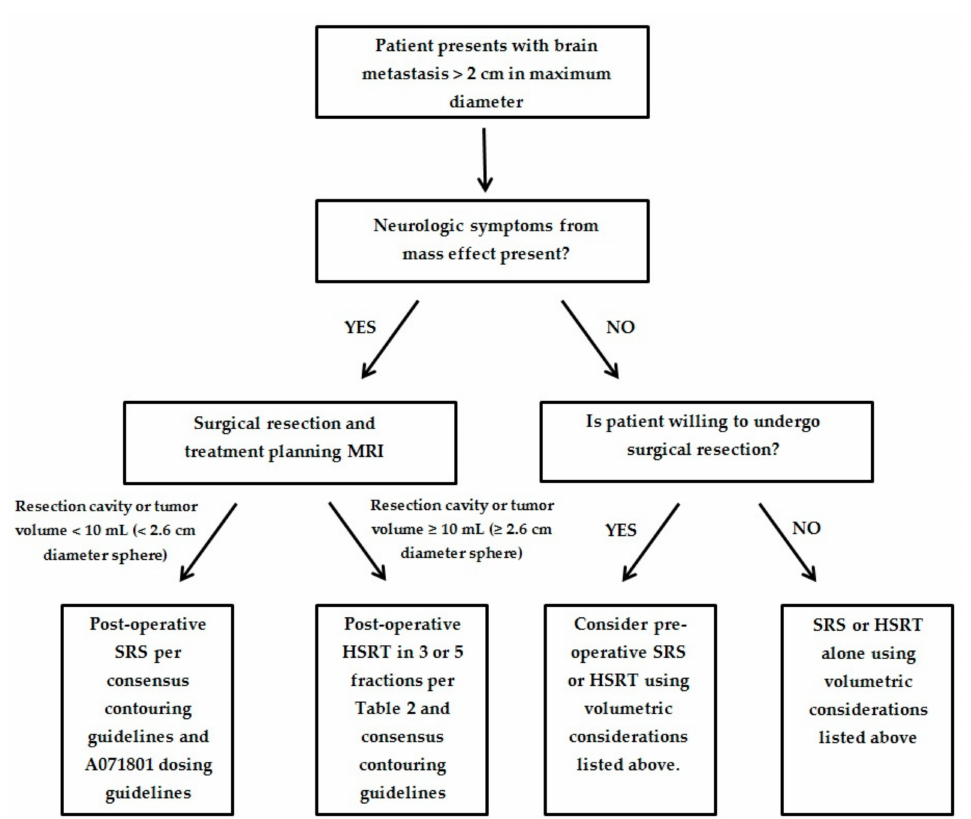
Figure 1. Proposed algorithm for management of patients with large brain